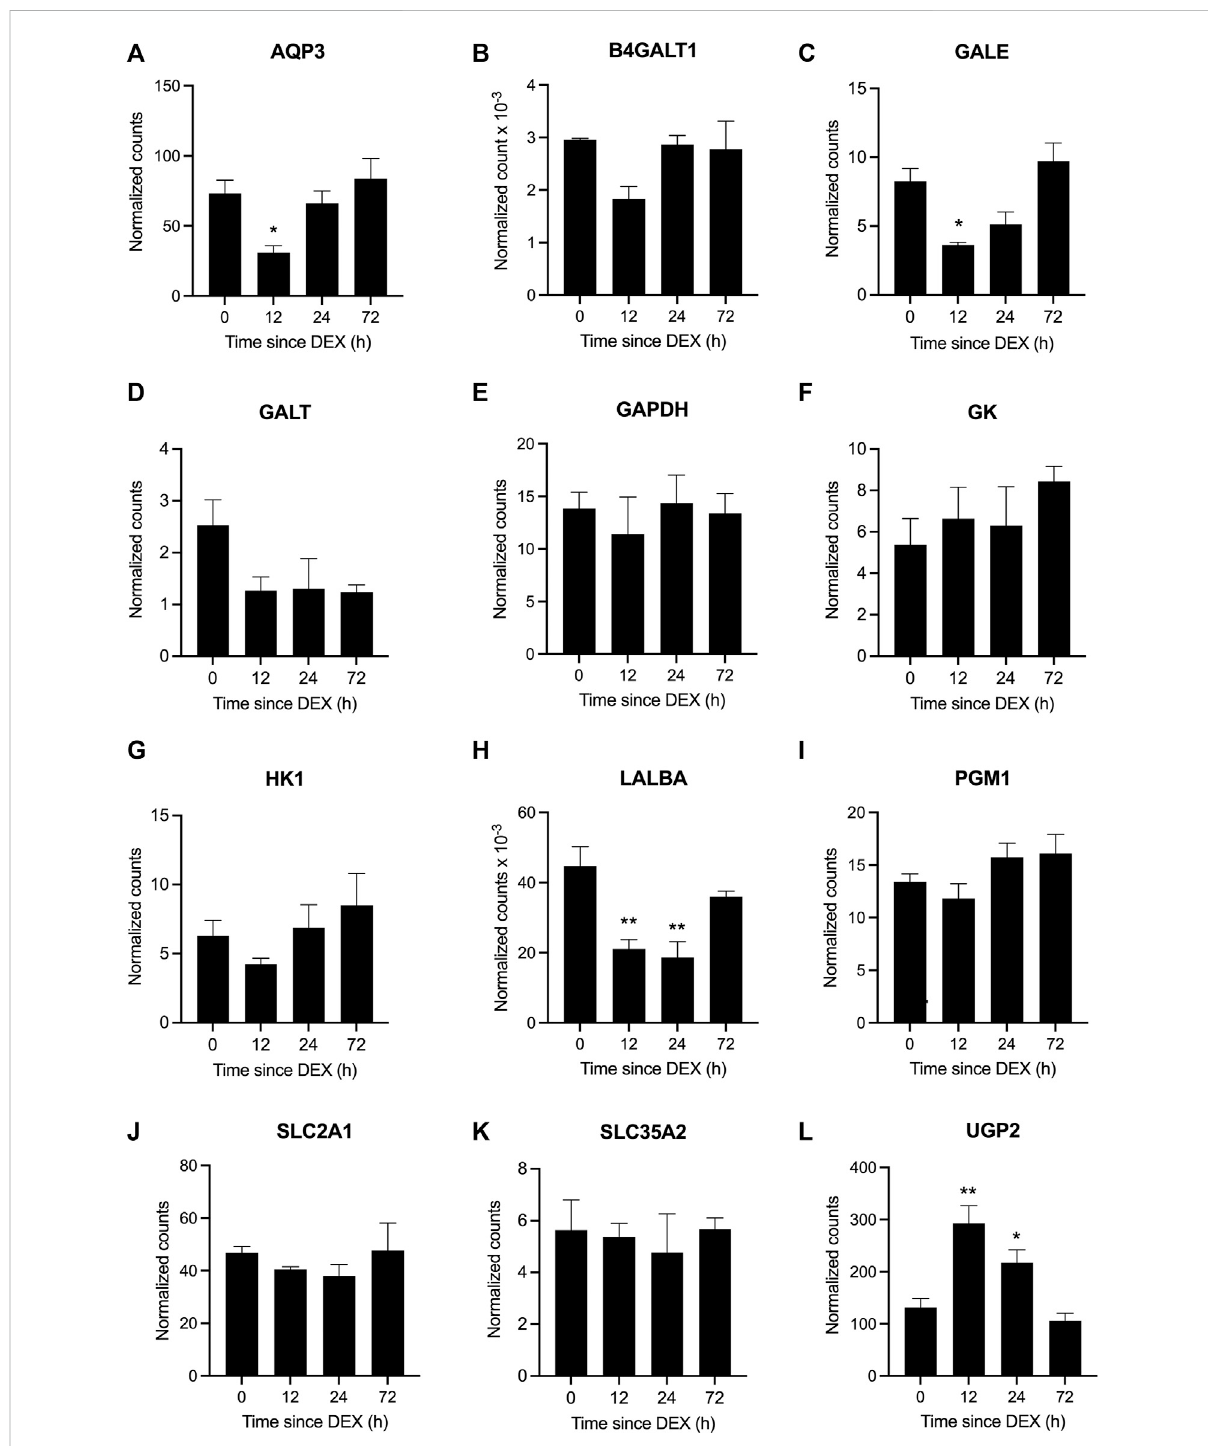
FIGURE 8 Differentialgeneexpressioninresponsetodexamethasone(DEX)forgenesinthelactosesynthesispathway.Datarepresentmean±SEM(n=3 cows) for the genes (A) aquaporin 3, AQP3, (B) beta-1,4-galactosyltransferase 1, B4GALT1, (C) UDP-galactose-4-epimerase, GALE, (D) galactose-1- phosphate uridylyltransferase, GALT, (E) glyceraldehyde-3-phosphate dehydrogenase, GAPDH, (F) glycerol kinase, GK, (G) hexokinase 1, HK,